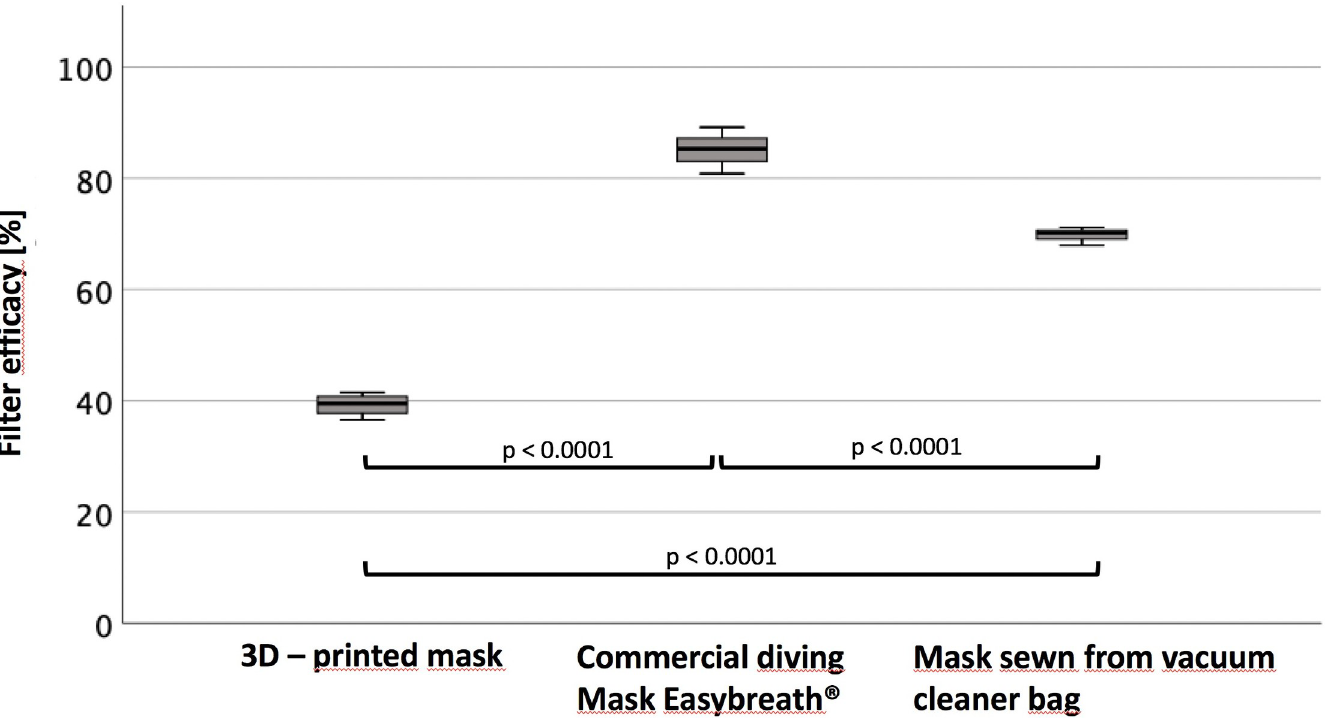
Fig 8. Efficacy. Filter efficacy of the respective filters and their statistically significant